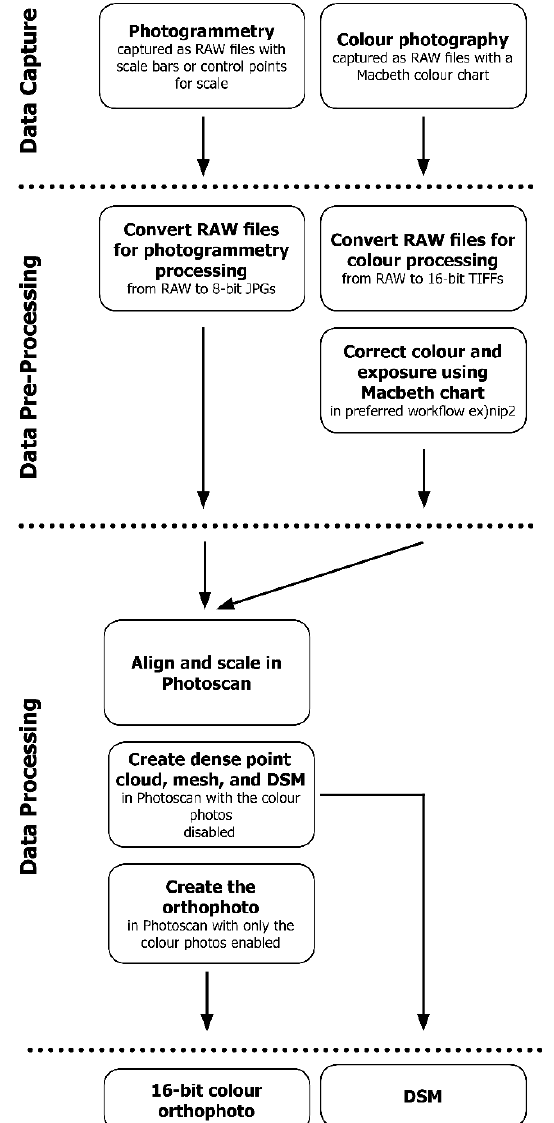
Figure 4. The workflow to produce a DSM and 16-bit colour orthophotos